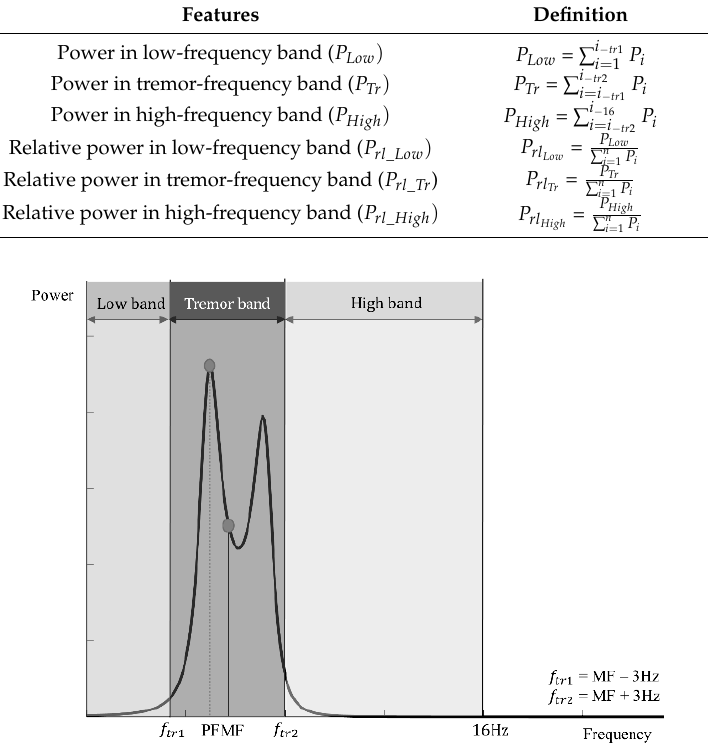
Figure 4. Graphically intuitive representation of the three frequency bands and spectral features in an averaged spectrum. The peak frequency (PF) and mean frequency (MF) are represented as an example. On the basis of the MF, the tremor frequency band is separated first; then, the remaining low- and high-frequency bands are determined.